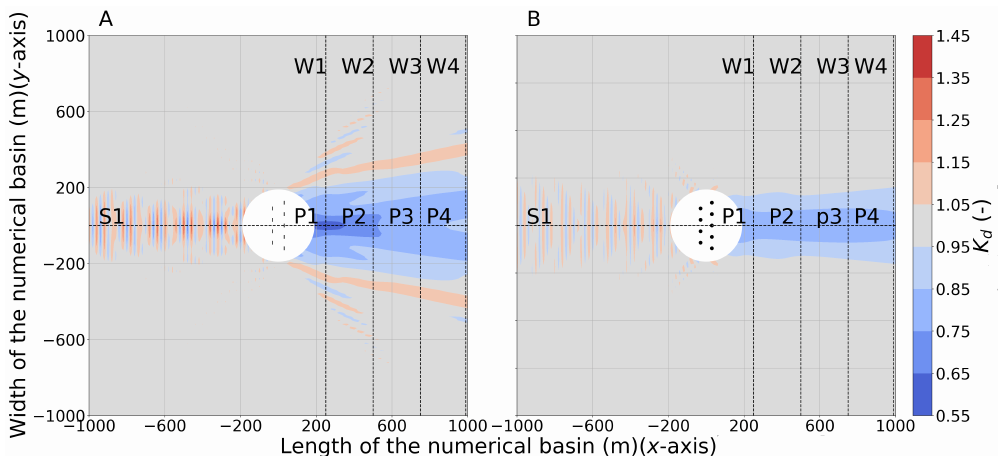
Figure 9. K d disturbance coefficient results for a 9-OSWEC array (O2) ( A ) and a 9-HCWEC (H2) ( B ) array interacting with regular waves with H = 2.0 m and T = 8.0 s. The coupling region is filled using a white solid circle which includes the WEC (indicated by black solid circles). Incident waves are generated from the left to the right. S1, W1, W2, W3, and W4 indicate the locations of cross-sections.